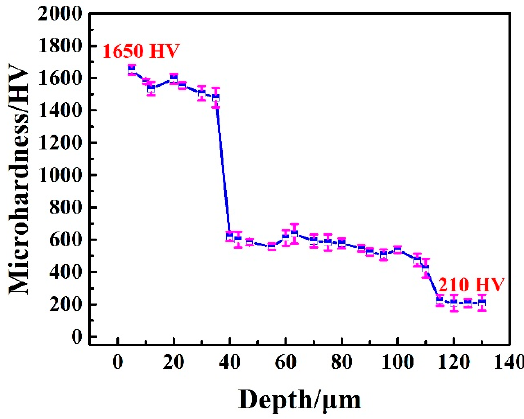
Figure 4. Microhardness distribution of the borocarburized layer.